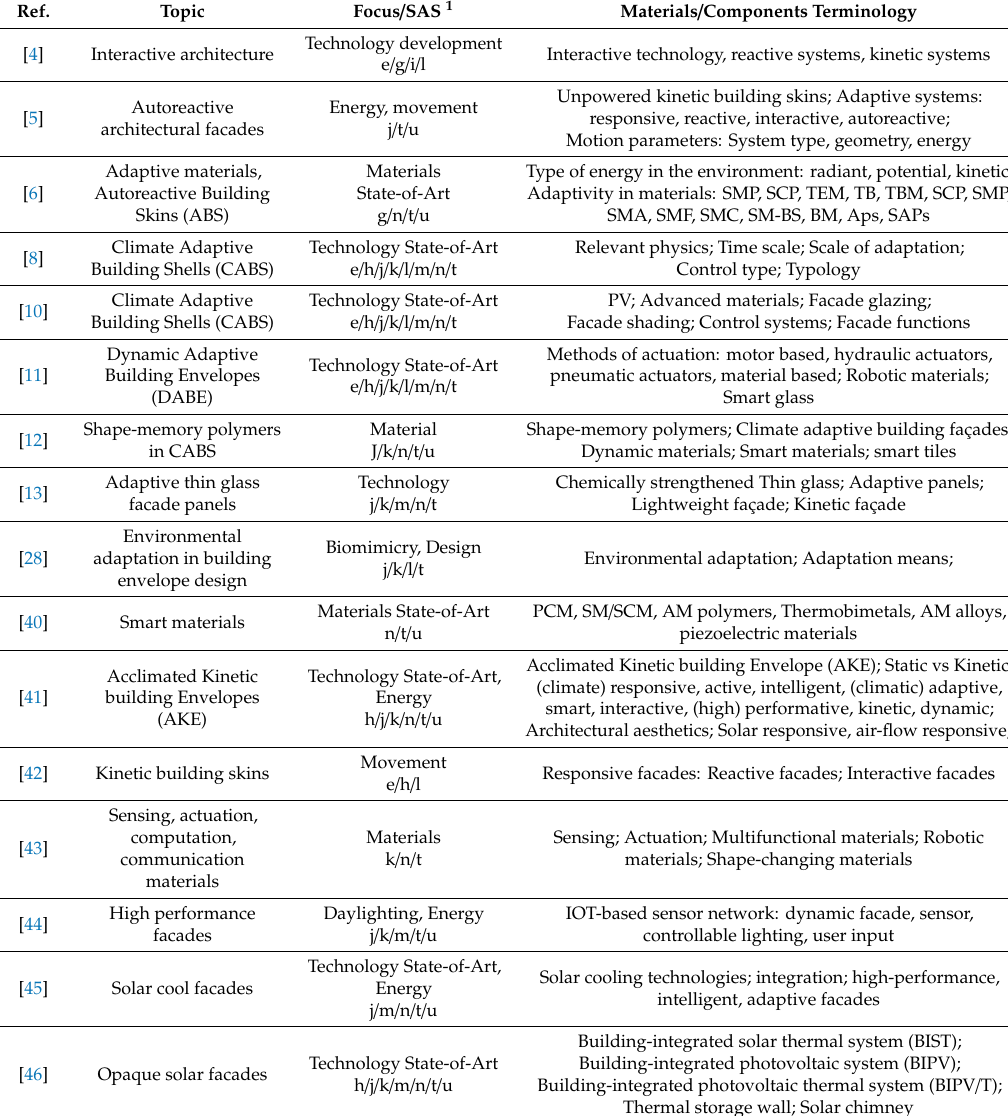
Table A1. Literature review on ABTs, relative materials and components: contents review.